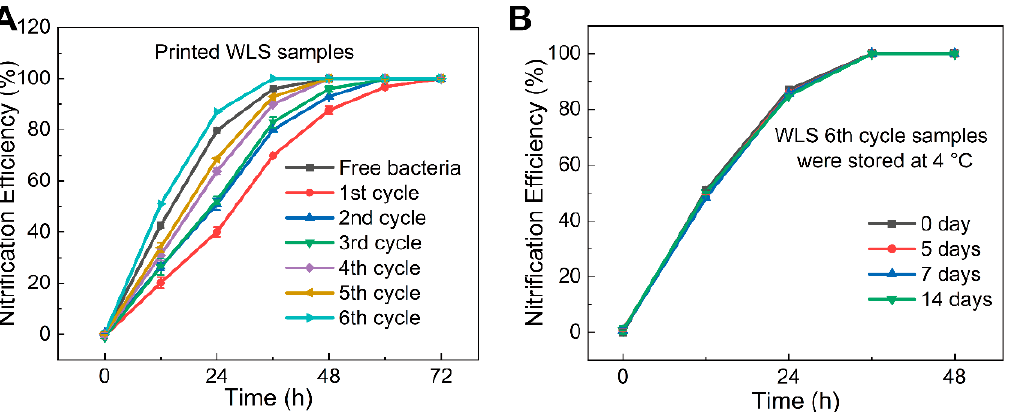
Figure 12. ( A ) The nitrogen removal cycle experiment of WLS samples. ( B ) The simulation of refrigerated storage experiment of 6th WLS samples.